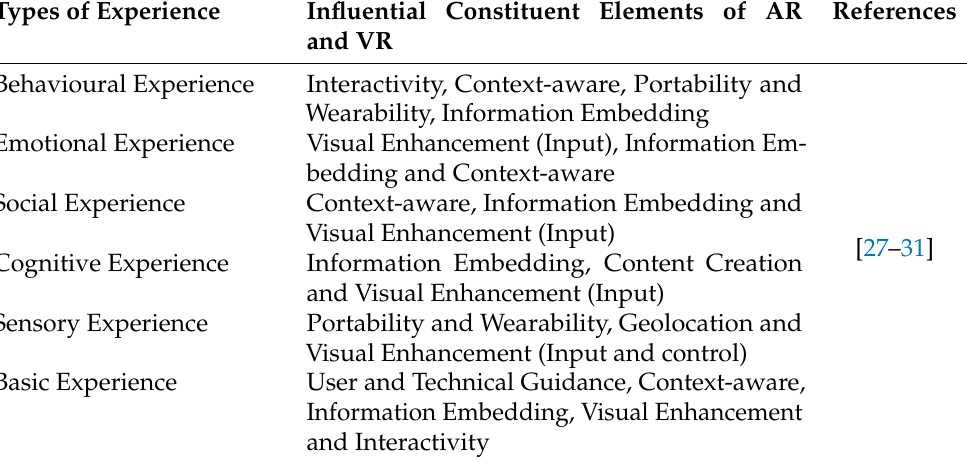
Table 2. Mapping of types of AR and VR experience with the constituent components that influence the 5G User Experience